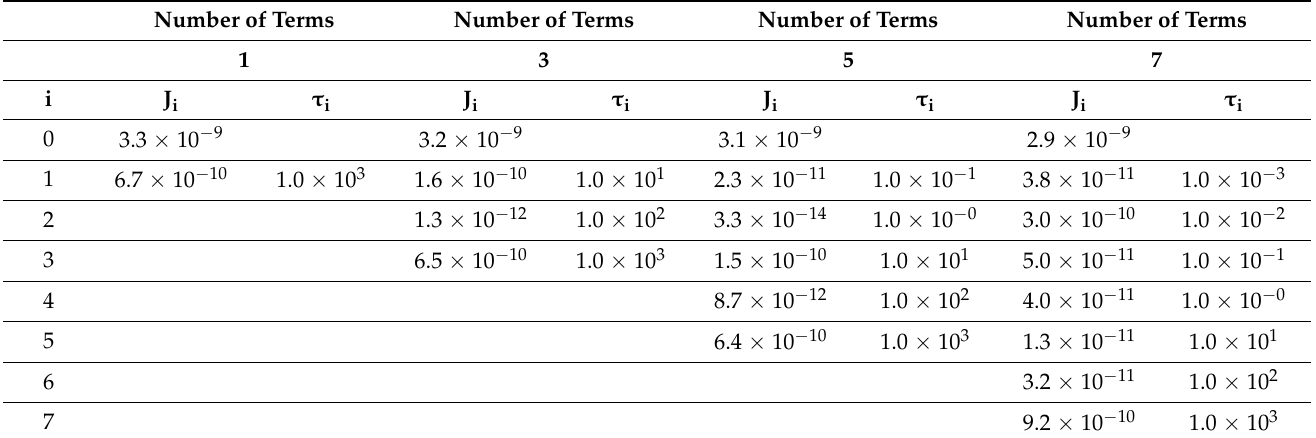
Table 1. Coefficients in creep modulus (PLA, d 1 = 0.09